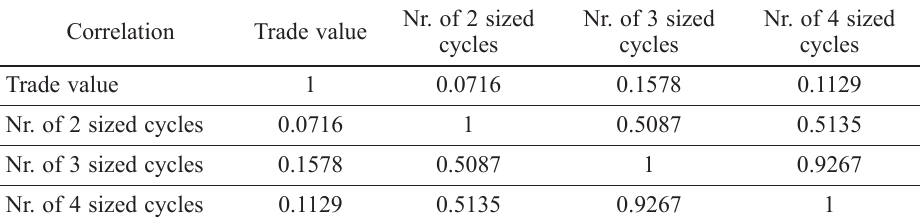
Table 2. Covariance matrix depicting the correlation between the independent and dependent variables in the linear regression